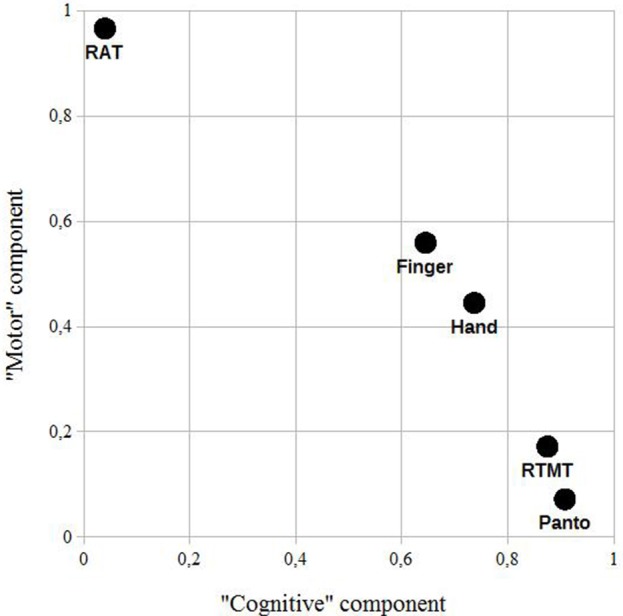
Patient sample: a rotated component plot using the absolute values of the rotated component matrix for a better visual inspection. RAT, reciprocal aiming task; RTMT, reciprocal trail making task; Finger, imitation of finger constellations; Hand, imitation of meaningless gestures; Panto, pantomime of the use of everyday objects.